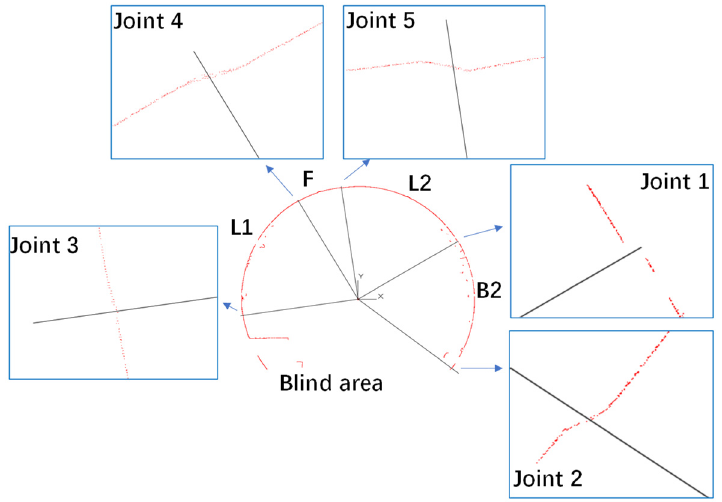
Figure 12. The identification of longitudinal joints.